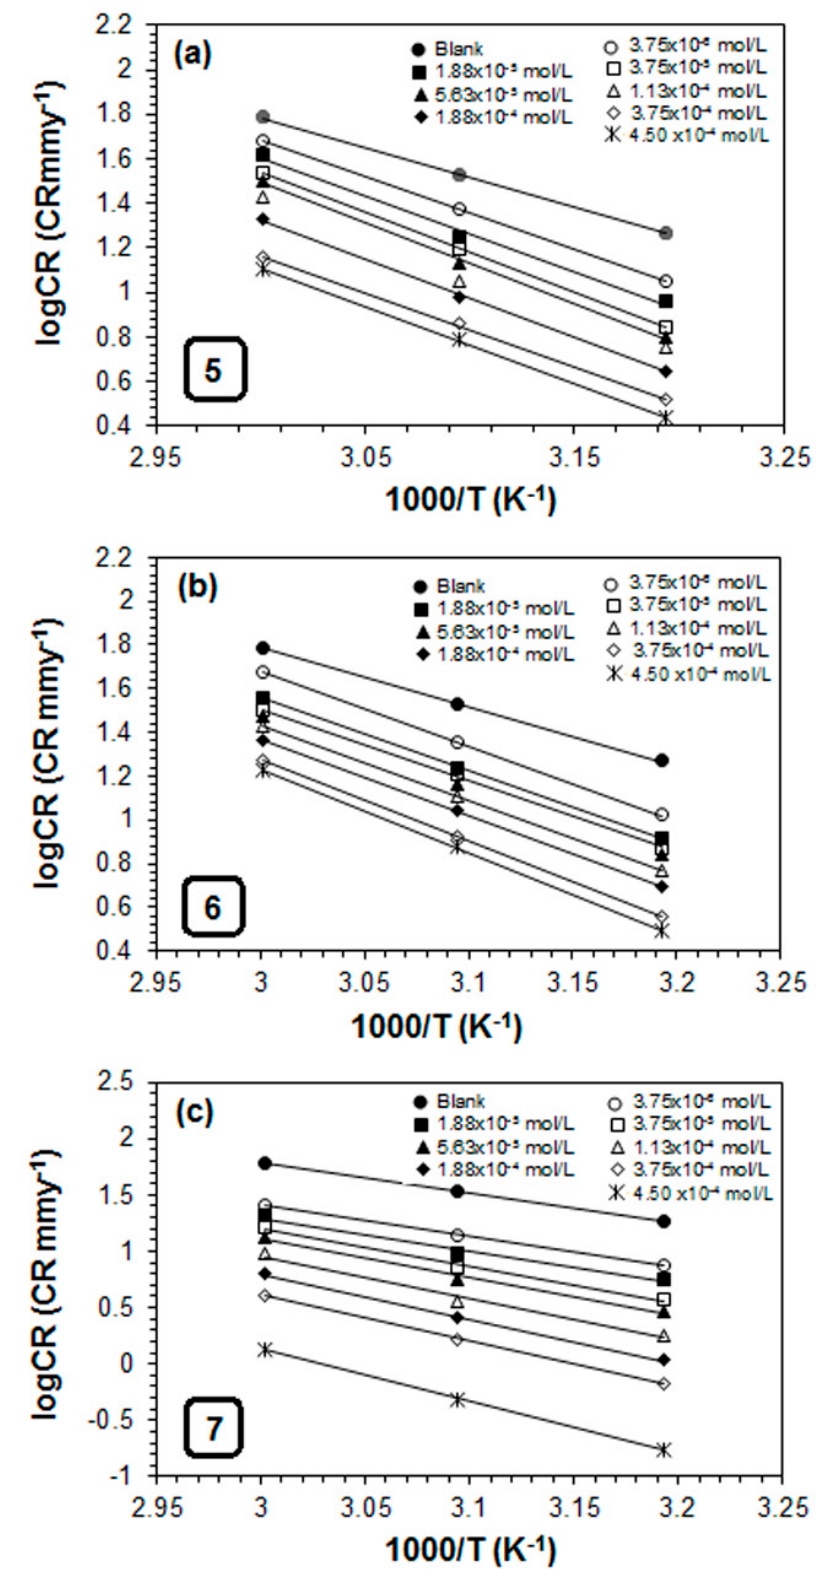
Figure 3. The log CR versus 1000 / T curves for mild steel corrosion in a 1 M HCl solution: ( a ) 5 , ( b ) 6 , and ( c ) 7